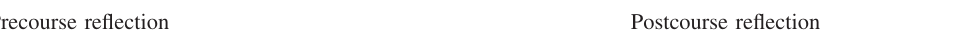
TABLE III. Examples of comments from the same student at the beginning and end of the semester. These comments showed resiliency to maintaining a limiting